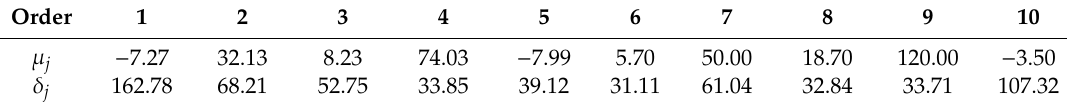
Table 3. Parameters of curve similarity model for on-ground status.